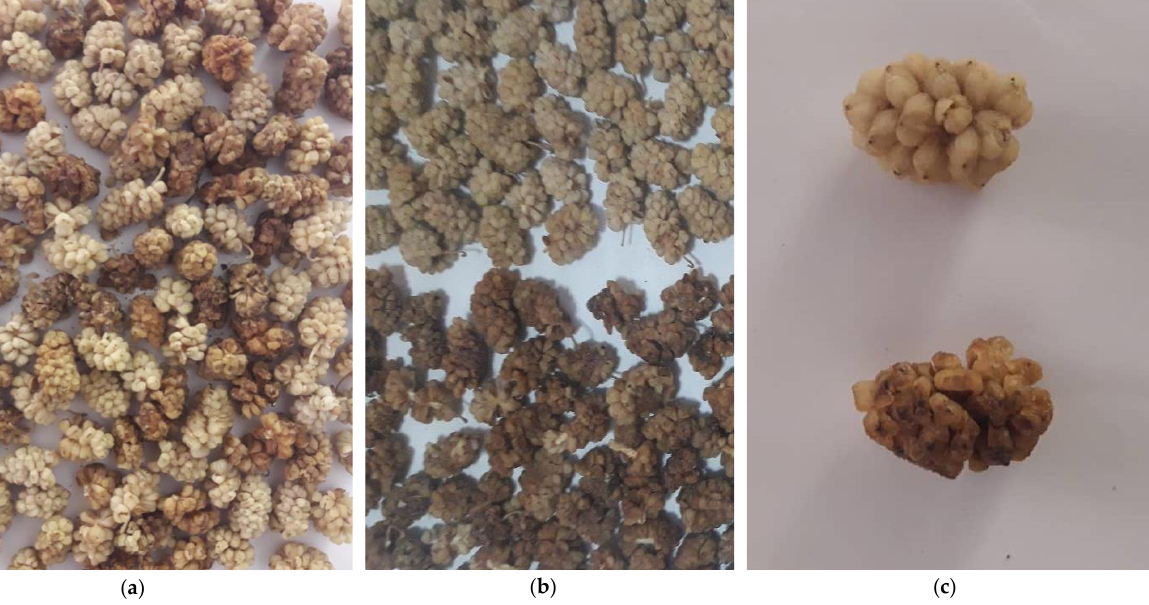
Figure 1. High- and low-quality dried white mulberry samples, ( a ) mixed combination, ( b ) manual grouping, and ( c ) magnified view of an individual sample.